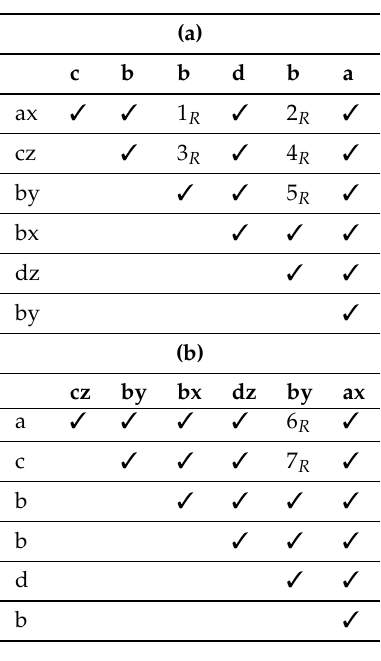
Table 12. MR-I results for response constraints: ( a ) activation; and ( b )